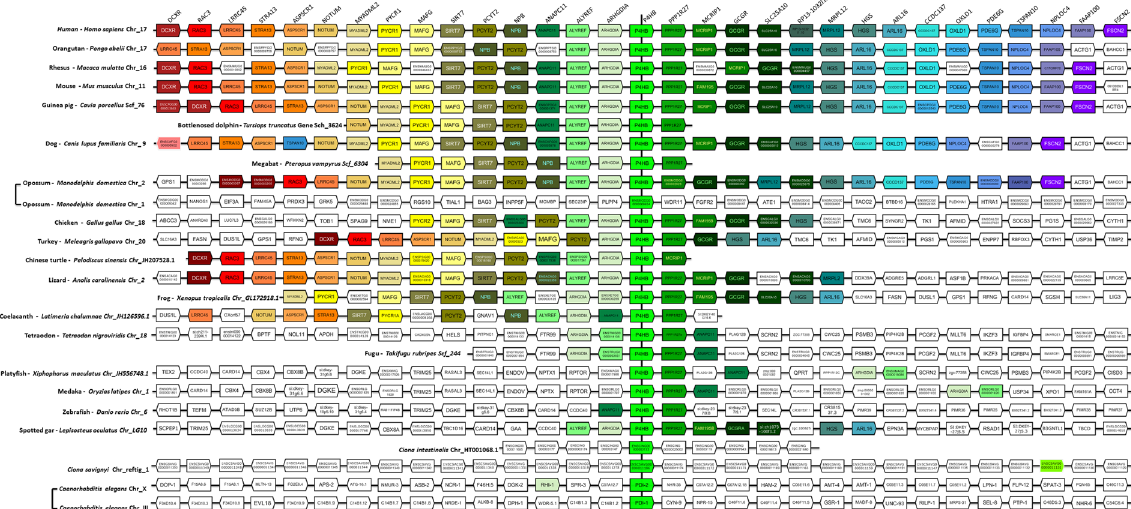
Figure 3. Alignment of the genomic region containing PDIA1/RhoGDI α cluster in Eukaryota. Gene names and positioning are based upon the Genomicus database (see methods). All species are aligned against Homo sapiens . The map is centralized in PDIA1 (P4HB)/RhoGDI α (ARHGDIA) gene pair. Genes are aligned in columms and kept in the order in which they appear in chromosomes (Chr) and scaffolds (Scf), without consideration for distance, while the transcriptional sense is represented by the pentagon tip. All orthologs are drawn with the same color and the lettering on the top refers to the Homo sapiens genes. In addition to the main genes of interest, the neighboring genes are included for reference.